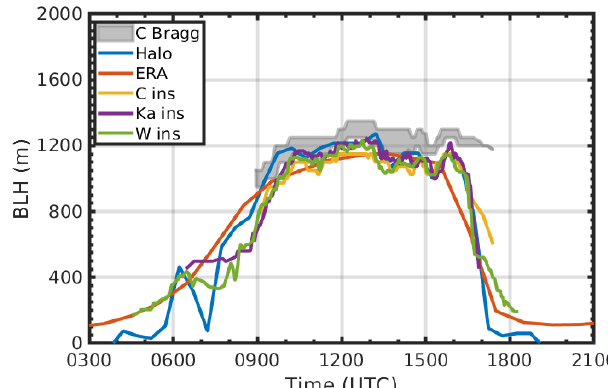
Figure 6. The CBLH derived from available radars compared to the CBLH retrieved from HALO Doppler lidar and ERA5 during 9 May 2018. All methods show good agreement during the after- noon but have discrepancies in the morning and